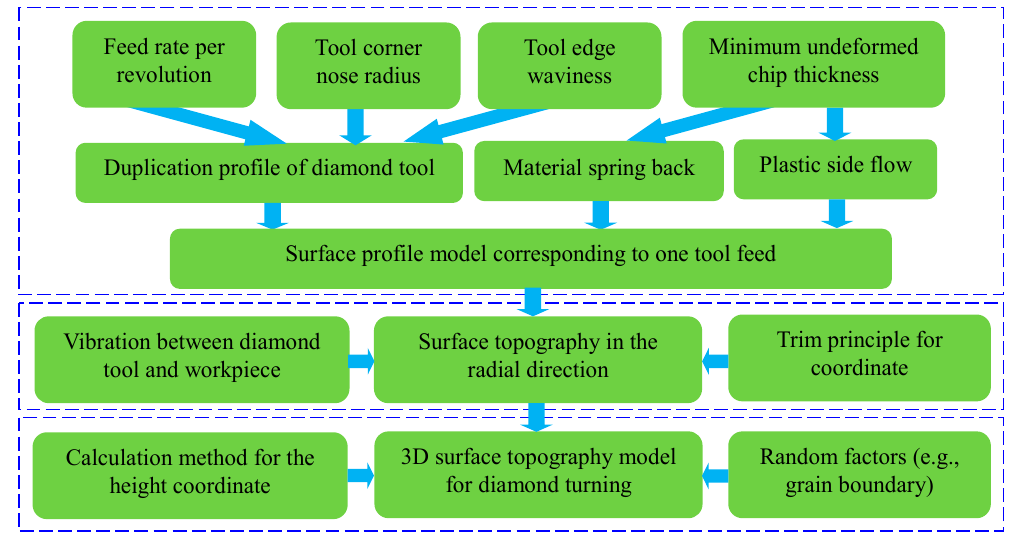
Figure 1. Influencing factors and corresponding issues in the modeling of surface topography.